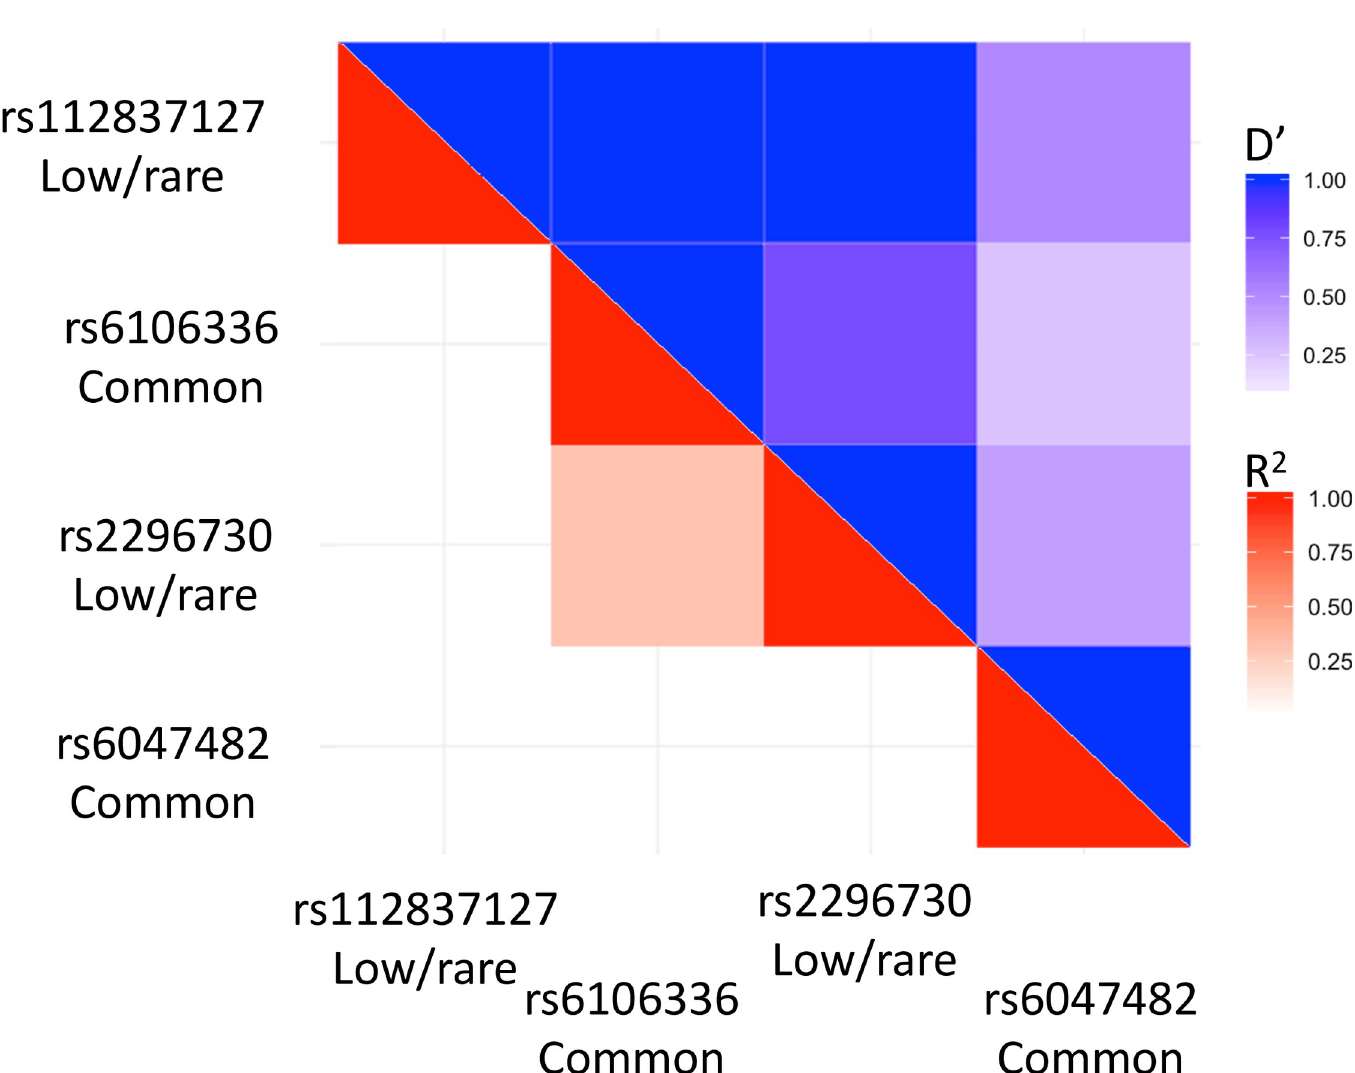
Fig 2. Patterns of Linkage Disequilibrium (LD) for rare, low-frequency and common variants associated with EwS at the chromosome 20p11.22–23 susceptibility locus. R 2 values are in shades of red while D’ values are in shades of blue, with darker values indicating higher degree of LD. All LD measures were estimated in LDlink using 1,000 Genomes Project European populations as the reference